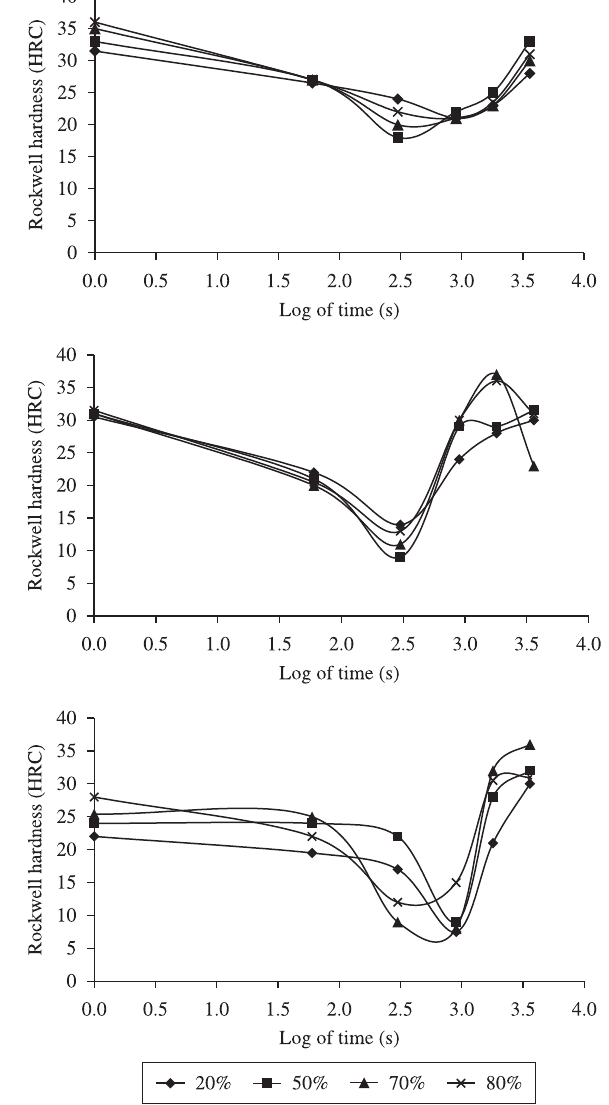
Figure 2. Rockwell hardeness vs. Annealing time plot for: a) 300 °C tempered martensite specimens treated at 740 °C; b) 500 °C tempered martensite specimens treated at 740 °C and c) 650 °C tempered martensite specimens treated at 740